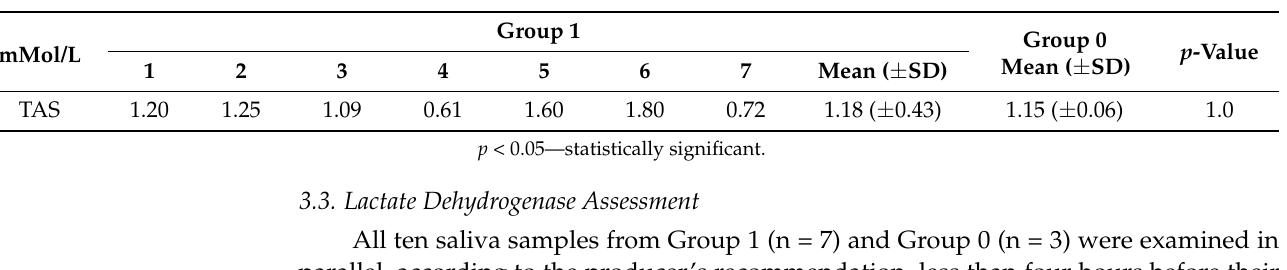
Table 2. Total antioxidant status (TAS) in mMol/L of Trolox equivalent for patients included in Group 1 compared to the mean values of the reference group (Group 0).